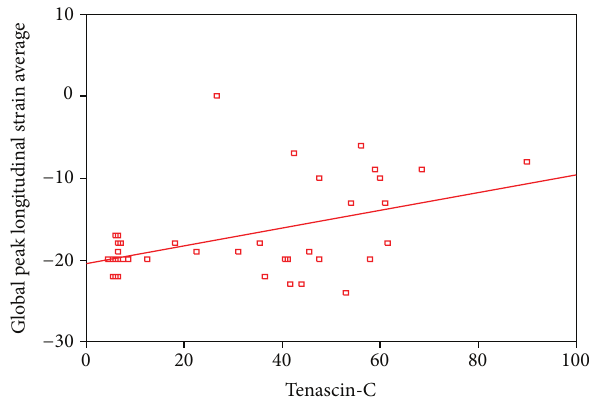
Figure3:Asignificantpositivecorrelationbetweenserumtenascin- c level and global peak longitudinal strain average in DCM patients.